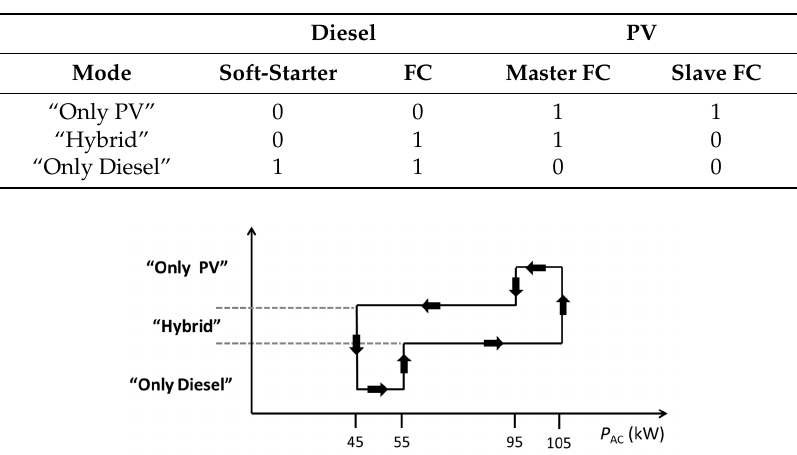
Figure 4. Available PV power thresholds with hysteresis for the different operating modes—“Only PV”, “Hybrid”, and “Only Diesel”.